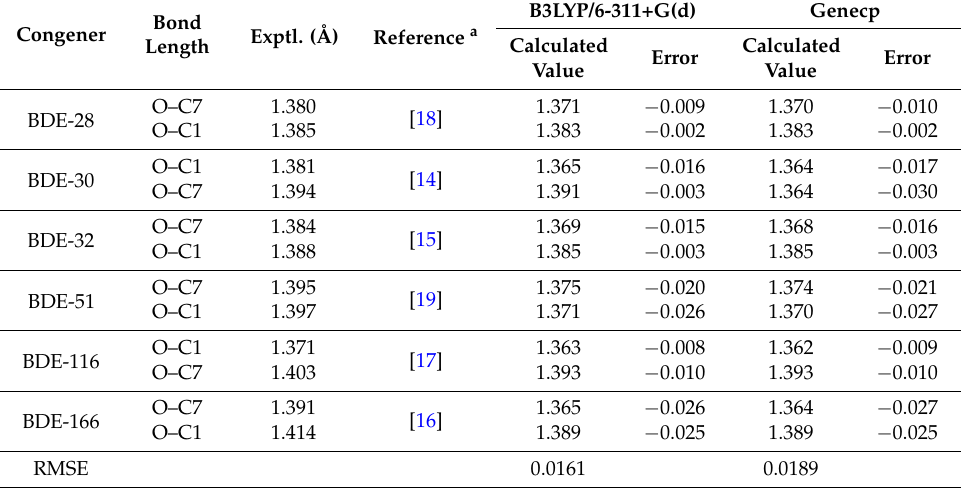
Table 3. Comparison of structural parameters for the selected PBDEs calculated at the B3LYP/ 6-311+G(d) and B3LYP/genecp (6-311+G(d)-SDD) levels with previous experimental